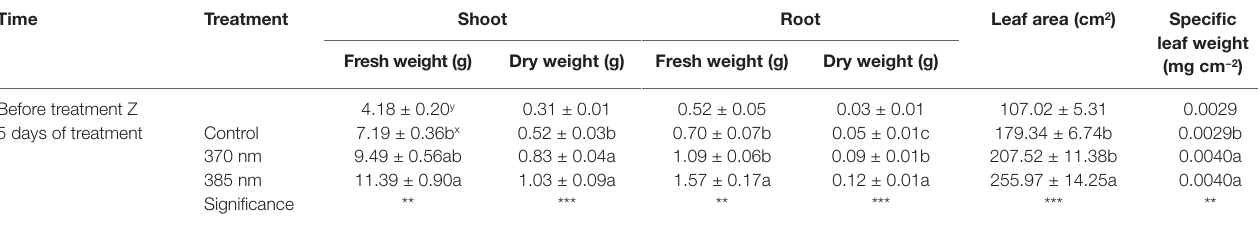
TABLE 2 | Growth characteristics of kale immediately prior to UV treatment and 5 days of UV treatments (n = 4).